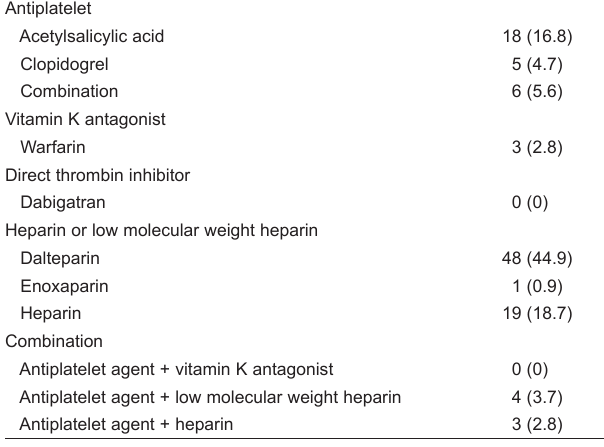
TABLE 4 Comorbidities of patients who developed thrombotic